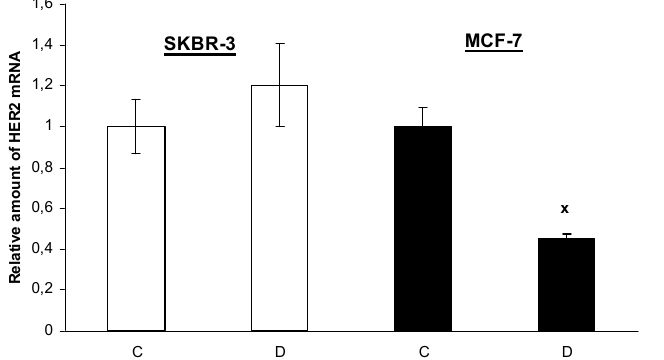
Data are presented as means ± SD of three independent experiments. The statistical significance is designated as follows: D vs. C x P <